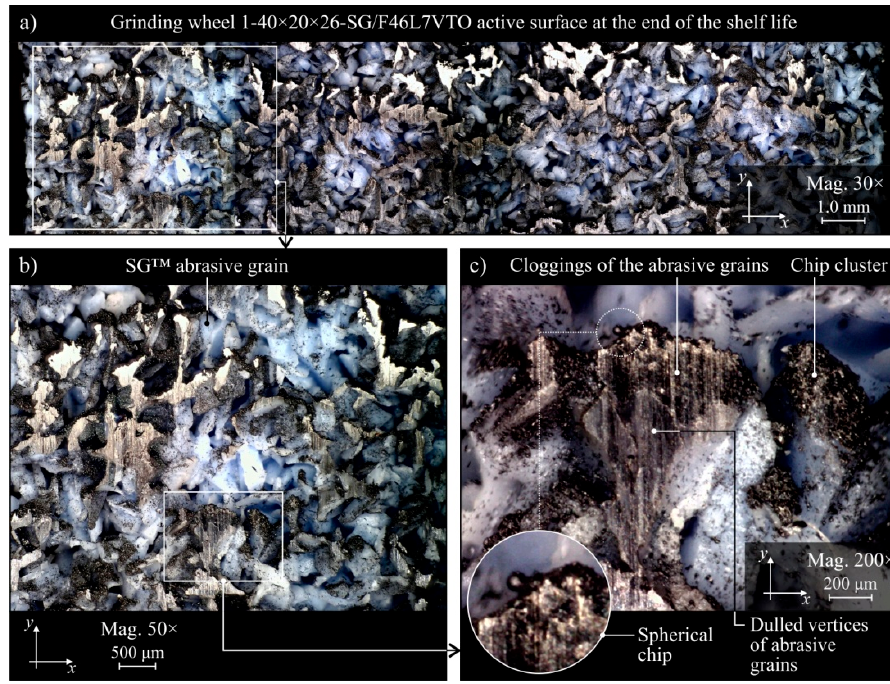
Figure 16. Microscope images of the grinding wheel active surface after machining under dry conditions, recorded with the Dino-Lite Edge AM6715MZT digital measuring microscope: ( a ) magnification 30×; ( b ) magnification 50×; ( c ) magnification 200×.